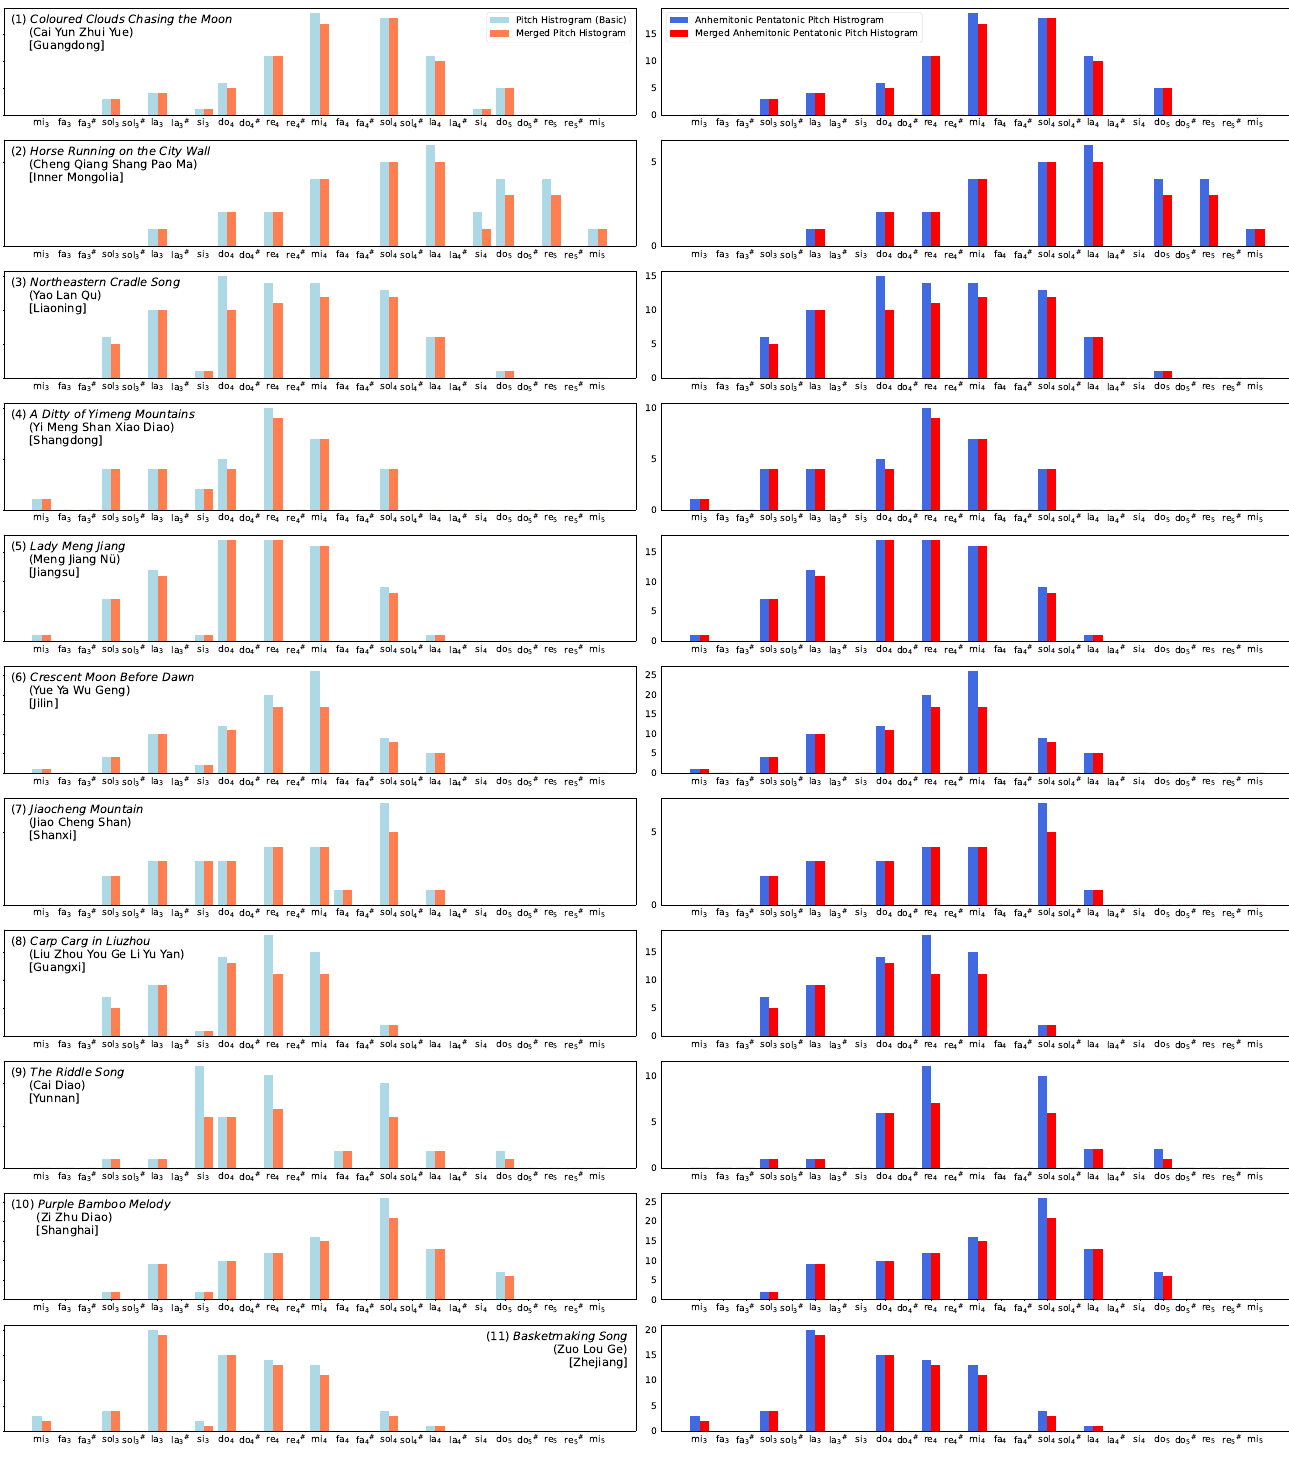
Figure 3. The movable do solfège-based basic pitch histograms (left column), merged pitch histograms (left column), anhemitonic pentatonic pitch histograms (right column), and merged anhemitonic pentatonic pitch histograms (right column) for 11 representative traditional Chinese anhemitonic pentatonic folk songs, with the original names (Hanyu Pinyin) in curved brackets and the provinces of the origin in square brackets. After removing the fa and si bins not belonging to the Chinese anhemitonic pentatonic from the basic and merged pitch histogram (left column, DoBell < 1), the basic and merged anhemitonic pentatonic pitch histograms (right column) conform to the bell shape ( DoBell =